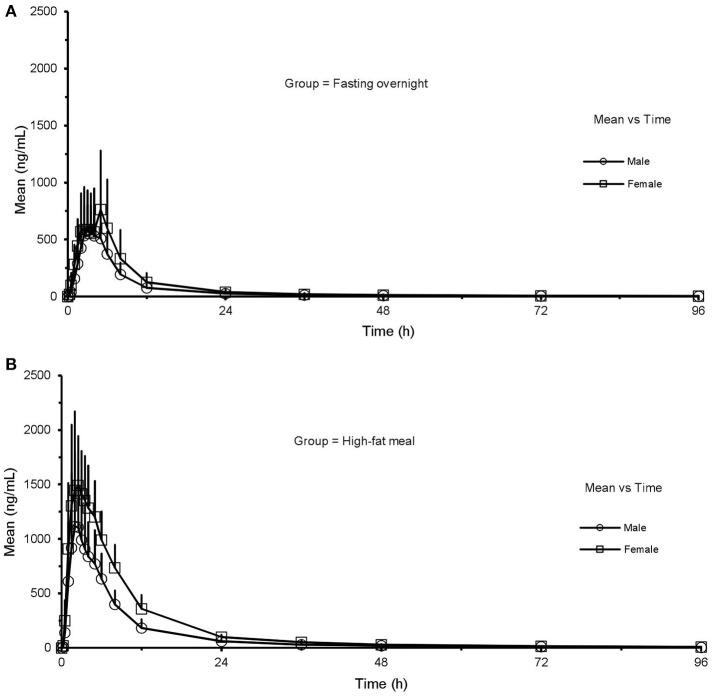
Mean (SD) plasma concentration-time profile of CK after oral administration of CK 200 mg under fasting overnight (A) and after a high fat meal (B) in male (n = 12) and female (n = 12) subjects, respectively. CK, compound K; All values are presented as mean ± standard deviation.